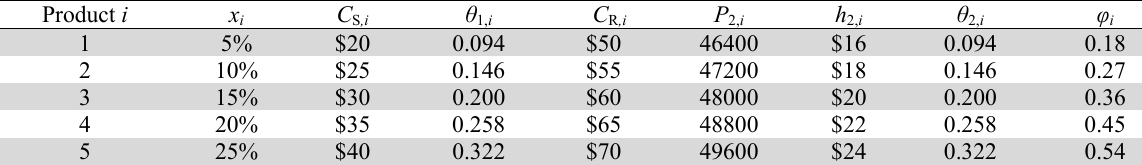
Assumption of variables’ values of a single-stage scheme of the same problem (2/2) Product